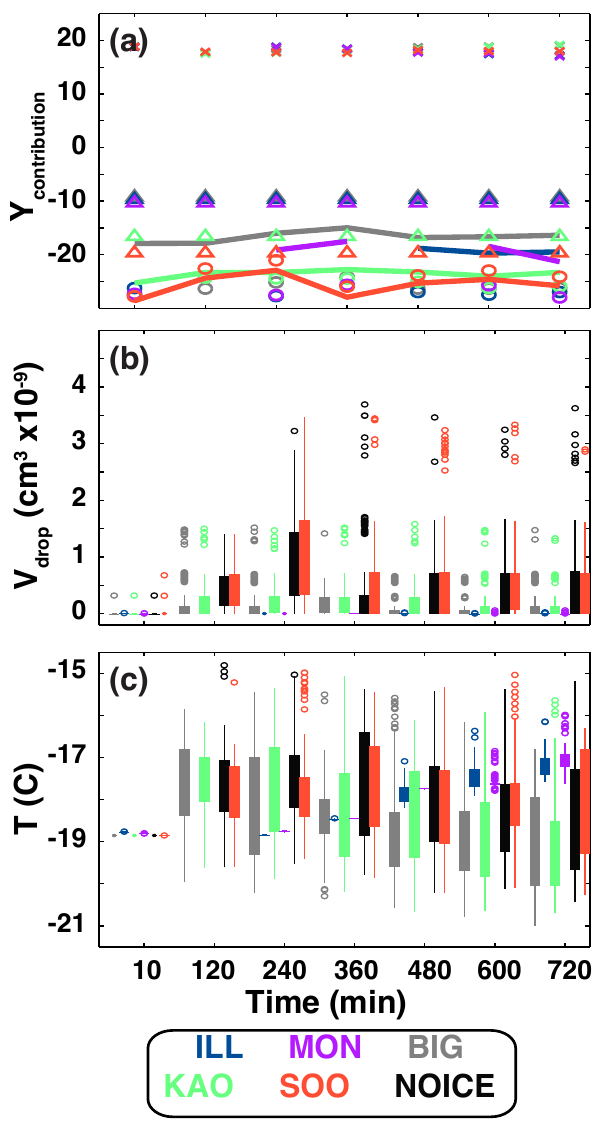
Fig. 5. Contributions to the immersion freezing parameterization plotted versus time. (a) demonstrates contributions from tempera- ture (x’s), particle freezing efficiency (B h,i , triangles), and droplet volume (circles). The lines are the sum of these three terms (NOICE line and markers are not included). (b) provides distributions of droplet volume for at cloud top as determined using a cloud wa- ter mixing ratio threshold, and (c) shows temperature distributions for the same